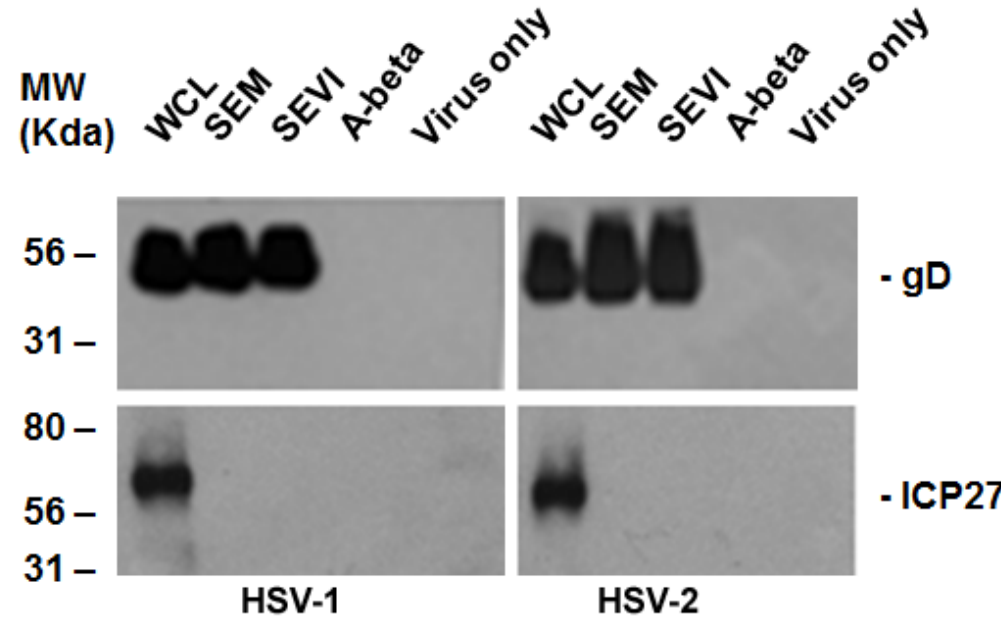
Figure 1. Amyloid-virus binding assay. ( Left ) 1 mL of HSV-1 (10 7 /mL) was incubated with 5 μg of SEVI or SEM amyloid fibrils for 1 h at 37 °C. Controls include virus alone and virus incubated with 5 μg of A-beta amyloid. The mixtures were centrifuged and the pellet was washed twice with MEM. The pellet was lysed in 2× Laemmli buffer and blotted using anti-ICP27 (non-structural protein) and anti-gD (envelope protein) antibodies. Whole cell lysates (WCL) of HSV-1–infected 293T cells were used as input controls for the Western blot; ( Right ) Similar conditions, but using HSV-2 instead of HSV-1. WCL = whole cell lysate made from HSV-infected HEK 293T